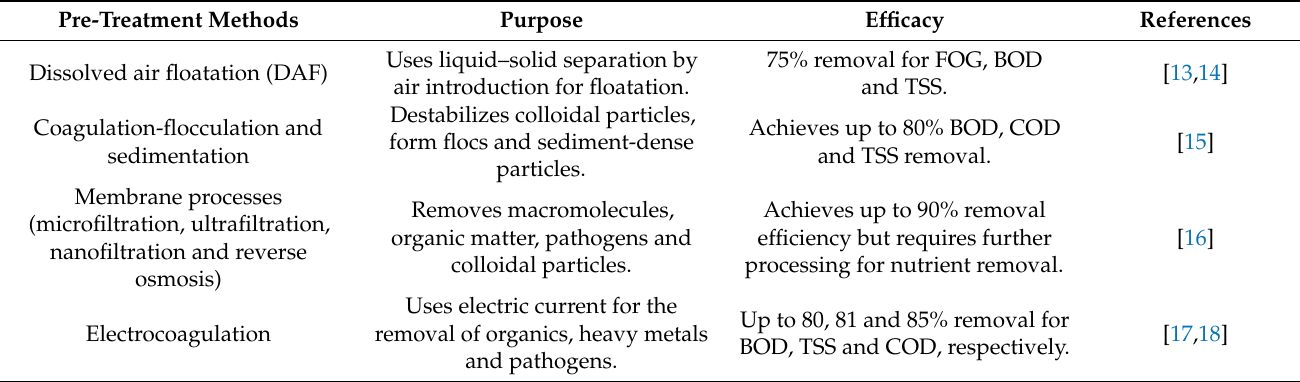
Table 1. List of pre-treatment methods used for the removal of COD, BOD and